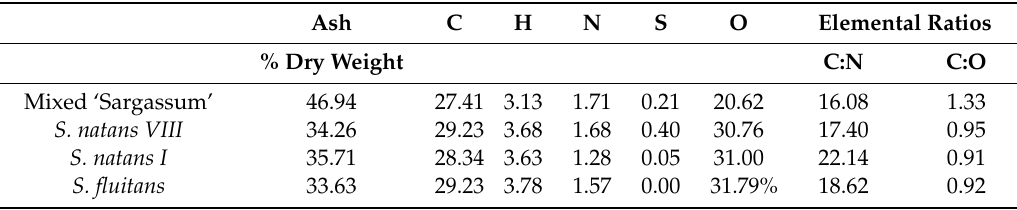
Table 4. The mean results of the CHNS analysis of Sargassum inundation (‘Mixed Sargassum’) and pelagic species of Sargassum from Turks and Caicos ( n = 2).